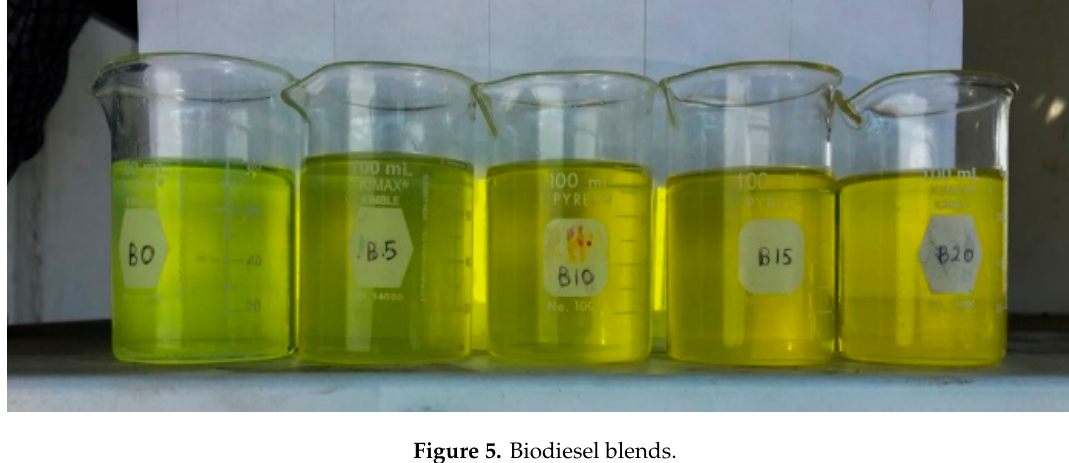
Figure 5. Biodiesel blends.